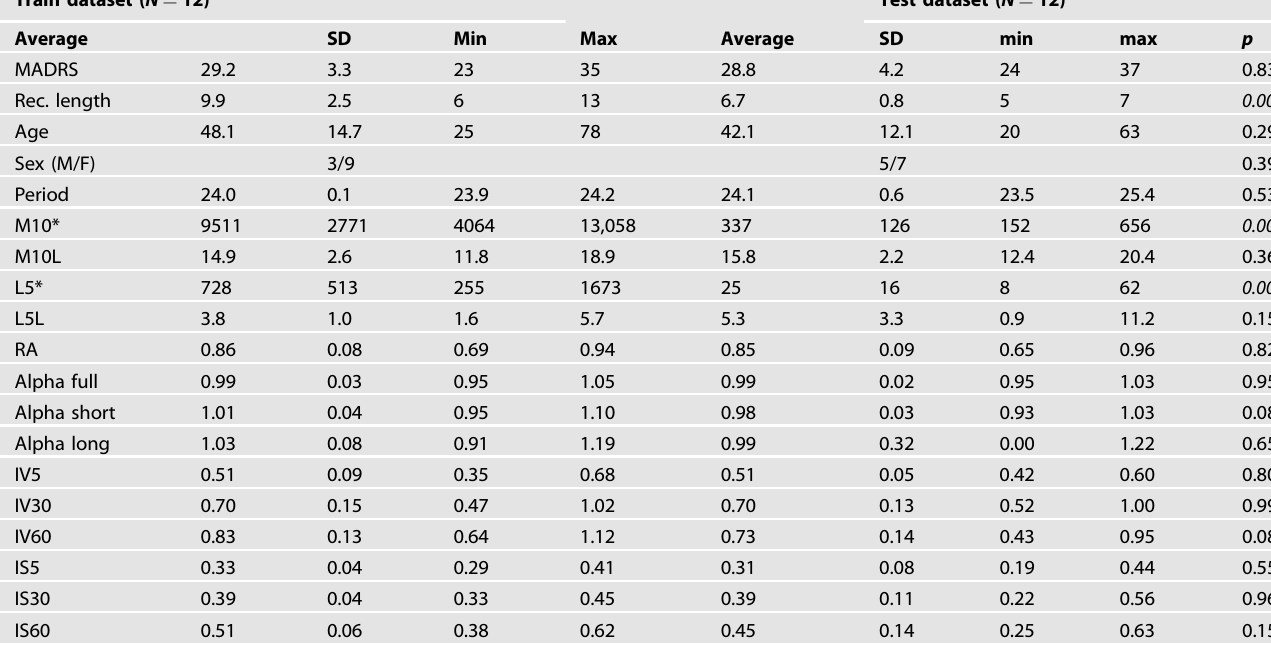
Table 1. Features extracted and comparison between